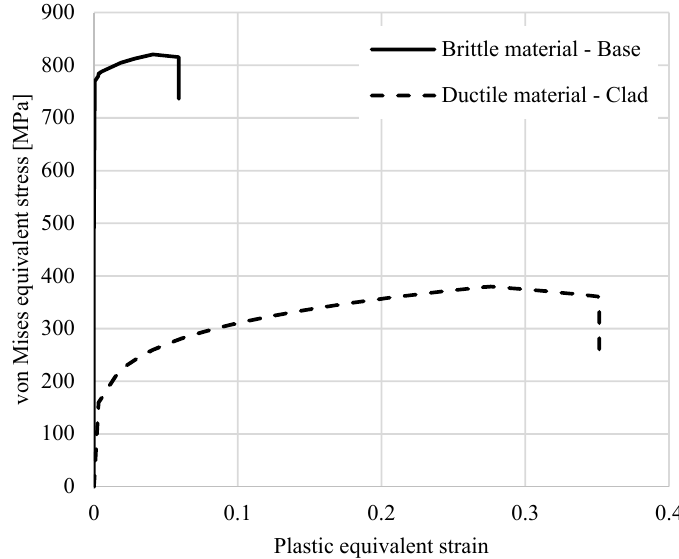
Figure 18. Developed brittle and ductile materials.